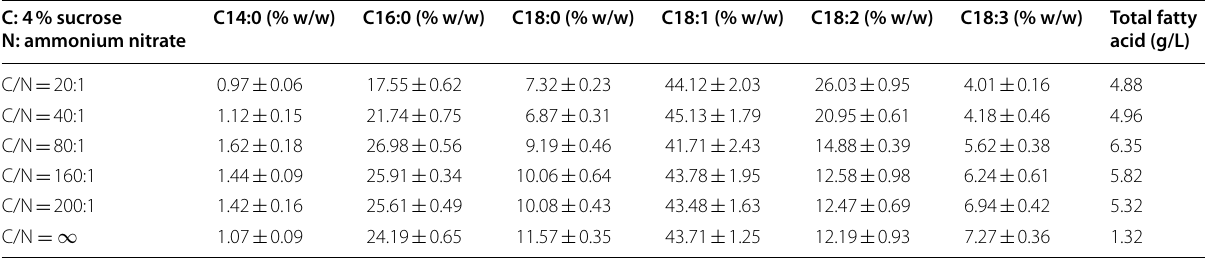
Table 2 Changes of fatty acid content of R-ZL2 in different C/N ratios